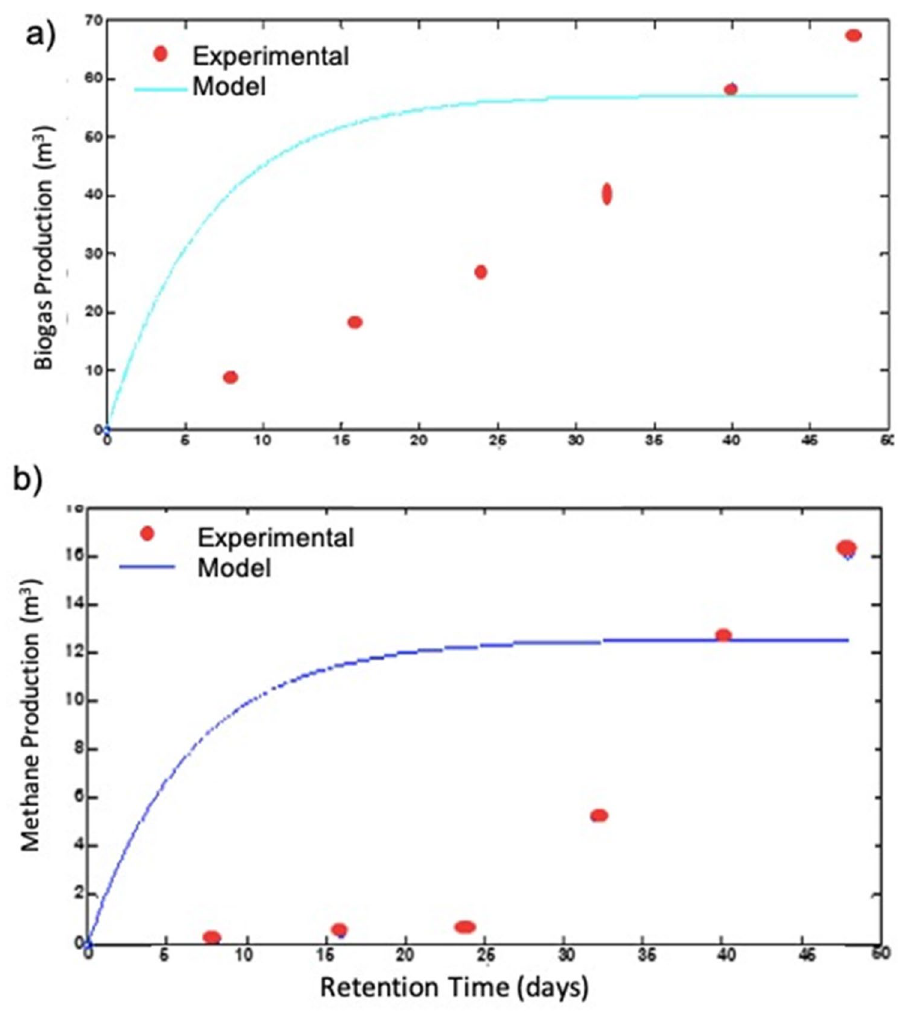
Figure 9. ( a ) Biogas production (m 3 ) as a function of time (days), simulation and experimental results, ( b ) methane gas production (m 3 ) as a function of time (days), simulation and experimental results at 25 ℃